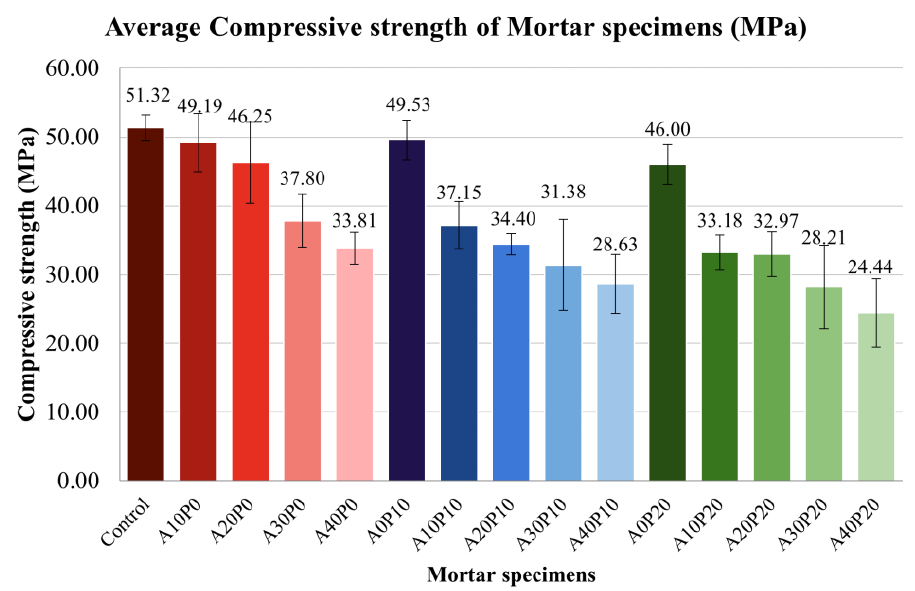
Figure 6. Average compressive strength of mortar specimens.